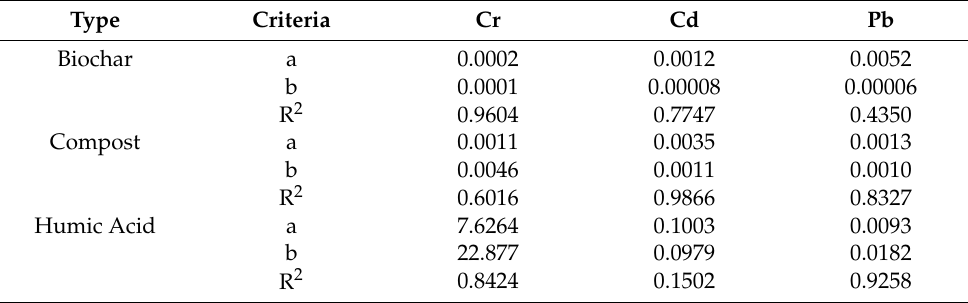
Table 2. The result of the isotherm Langmuir model.